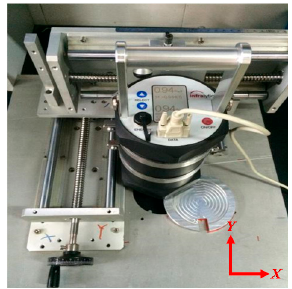
Figure 2. Wall film thickness measurement device.